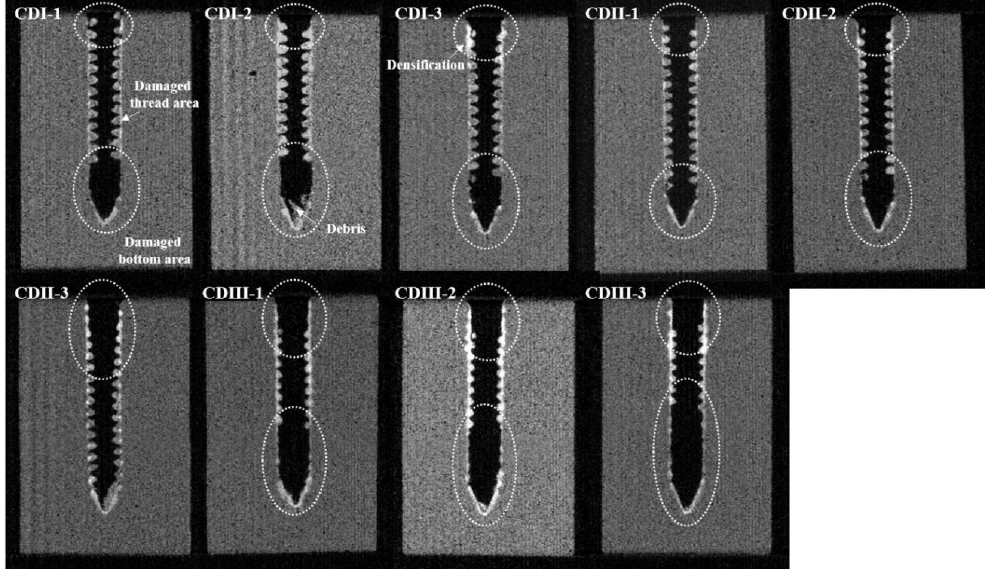
Figure 9. Cross sectional images of the artificial bone (grade 10) with the screw removed after the pullout test.